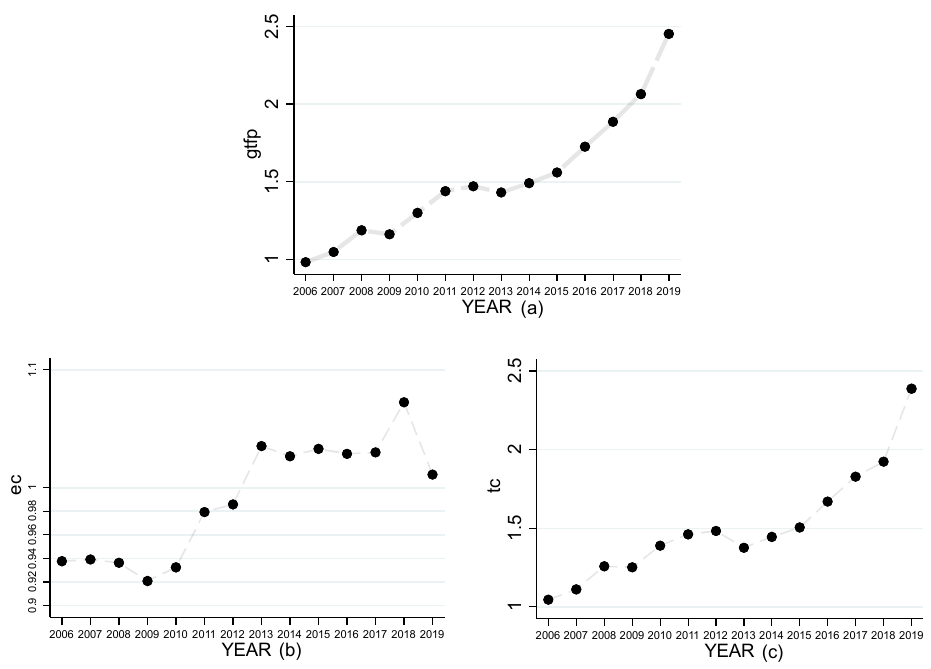
Figure 1. Technical efficiency change, Technical progress change and GTFP trend graphs. ( a ) indicates the trend of GTFP ; ( b ) indicates the trend of technical efficiency change; ( c ) indicates the trend of technical progress change.